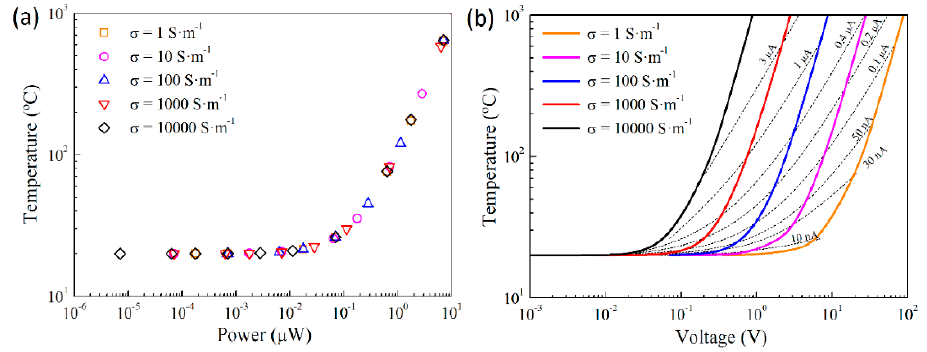
Figure 3. Temperatures reached at the center of the nanowire with different electrical conductivities as a function of ( a ) the power dissipated, and ( b ) the voltage applied to a nanowire diameter of 60 nm and a thermal conductivity of κ = 1 W·m − 1 ·K − 1 . Reproduced from Ref. [40], with permission from